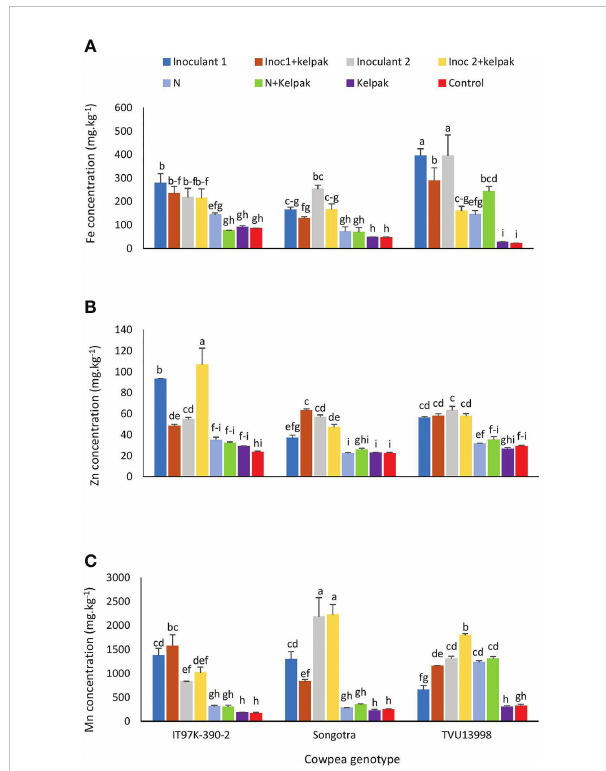
FIGURE 5 Interactive effect of genotype x treatment on the concentrations of Iron (A) . Zinc (B) and Manganese (C) in the leaves of three cowpea genotypes, planted under glasshouse conditions. Inoculant 1(Inoc 1) = B . yuanmingense strain CB756 (commercial inoculant), Inoculant 2 (Inoc 2) = Bradyrhizobium sp. strain TUTVUSA (closely related to B . daqingense ), control = no inoculant and no kelpak, N= 5mM KNO 3, control= no inoculation and no kelpak. Vertical lines on bars represent S.E. Bars followed by dissimilar letters are signi fi cant at ***p ≤